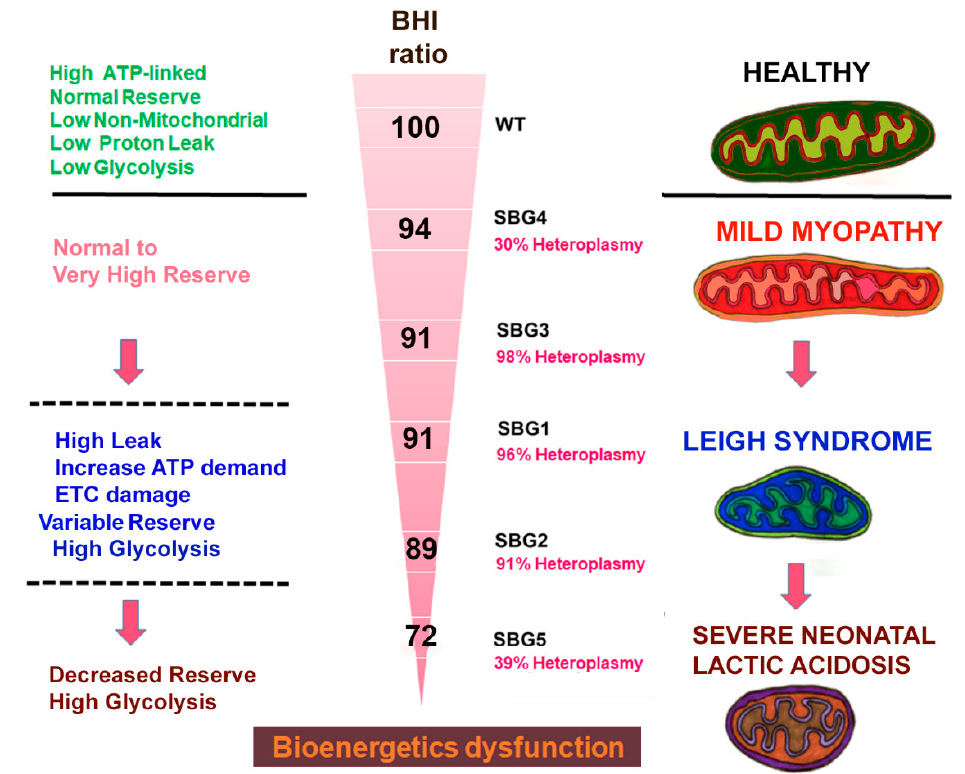
Figure 5. A model for predicting disease severity in LS. Our results indicate that during stress triggered by specific pathogenic mtDNA variants or other factors, cells SBG4-FB ( MT-ND3-T10158C ) with high spare reserve capacity (SRC), low heteroplasmy, and high composite BHI ratio exhibit delayed onset and mild clinical symptoms. However, as SRC and composite BHI ratio decreases, cells SBG5-FB ( MT-ND5-T12706C ) are unable to handle stress and exhibit early-onset and severe clinical symptoms despite low heteroplasmy levels. Whereas cells carrying pathogenic disease mtDNA variants in ATP6 gene SBG1-FB ( MT-ATP6-T8993G ), SBG2-FB ( MT-ATP6- T8993G ), SBG3-FB ( MT-ATP6-T9185C ) exhibit very high heteroplasmy levels, lower composite BHI ratio when compared with control BJ-FB, and can be grouped as ‘intermediate’ in disease severity.